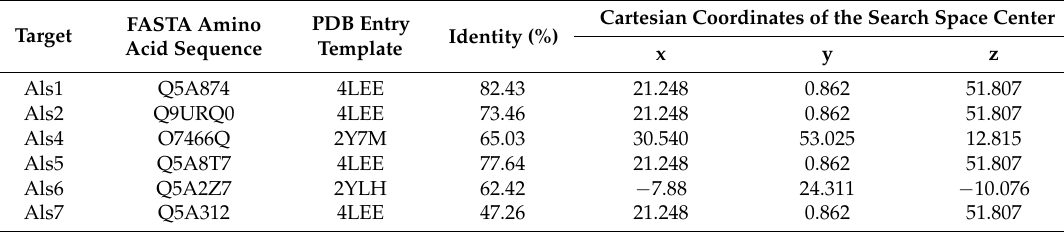
Table 10. Structures built by homology modeling (not available from Protein Data Bank).